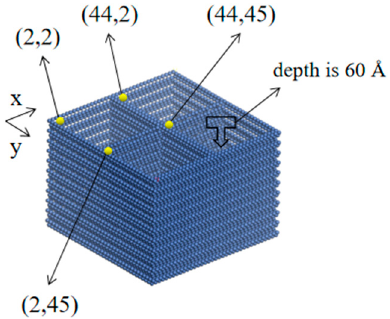
Figure 6. The model of the Ni plate surface.